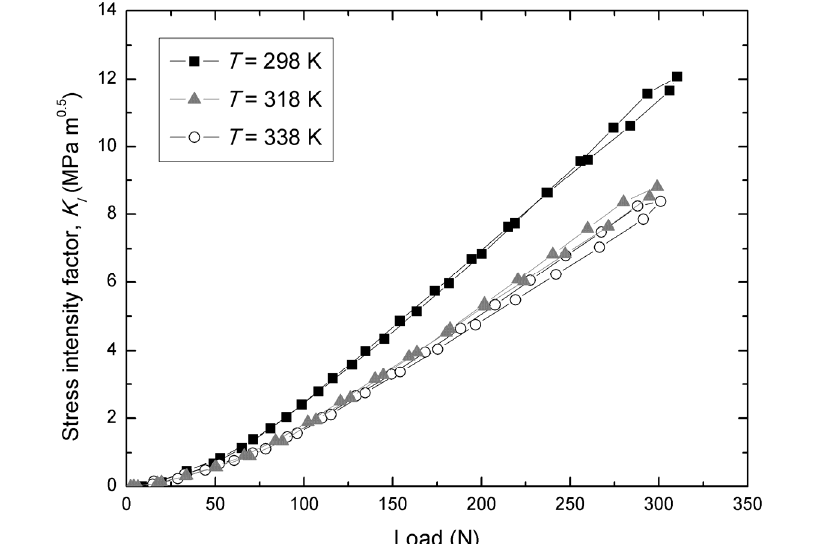
Figure 4: Evolution of the calculated Stress Intensity Factor (SIF) in a cyclic test for different operating temperatures.